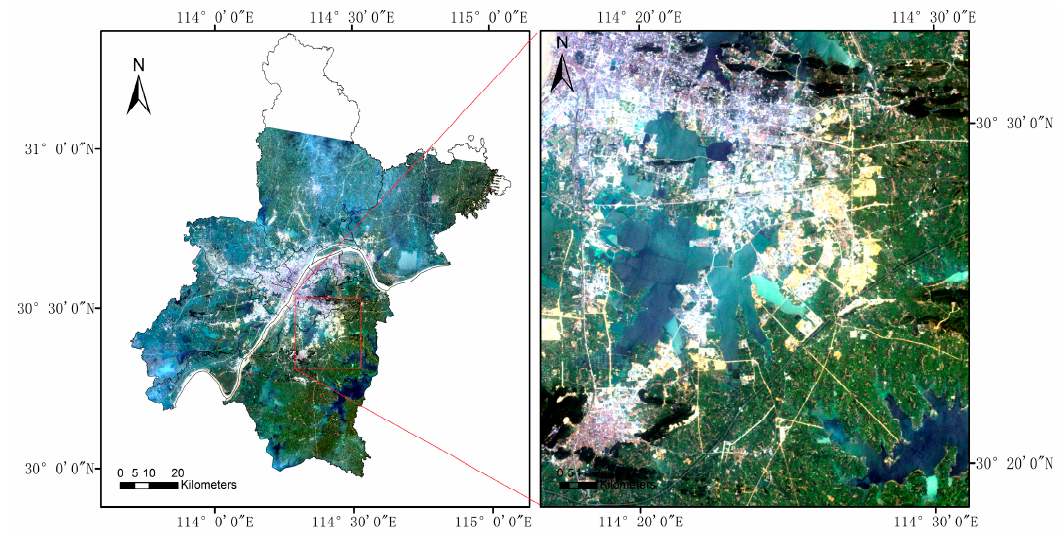
Figure 2. The TM sample on 31 July 2007. The right panel shows the partial detail.